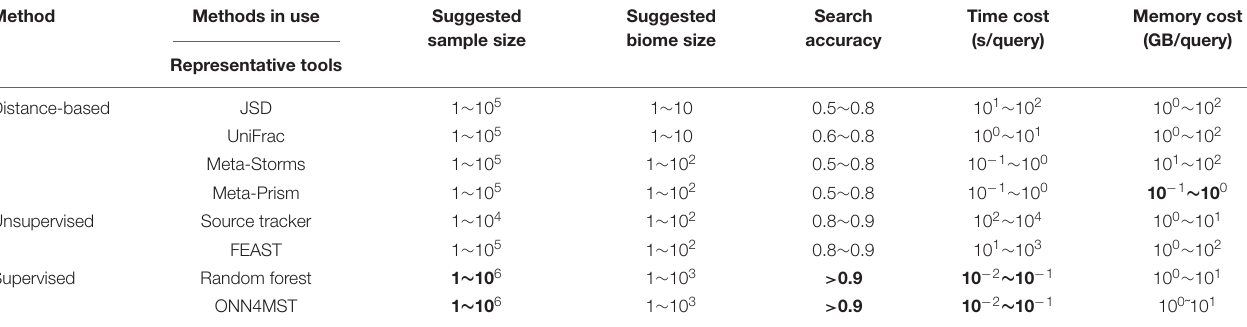
FIGURE 3 | Datasets with varied complexities have provided source tracking tasks with different difficulties. Soil datasets contain samples mainly from soil biomes. Water datasets contain samples mainly from water biomes. Human datasets contain samples mainly from human biomes. Mixed datasets contain samples from all biomes in MGnify. Estimations of the number of biomes and samples are based on the MGnify database in the year 2020. TABLE 2 | The advantages and disadvantages of current methods for microbiome sample comparison and